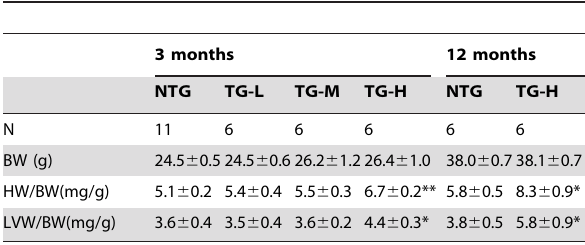
Table 1. Gravimetric Data for the TNNI3K Transgenic Mouse